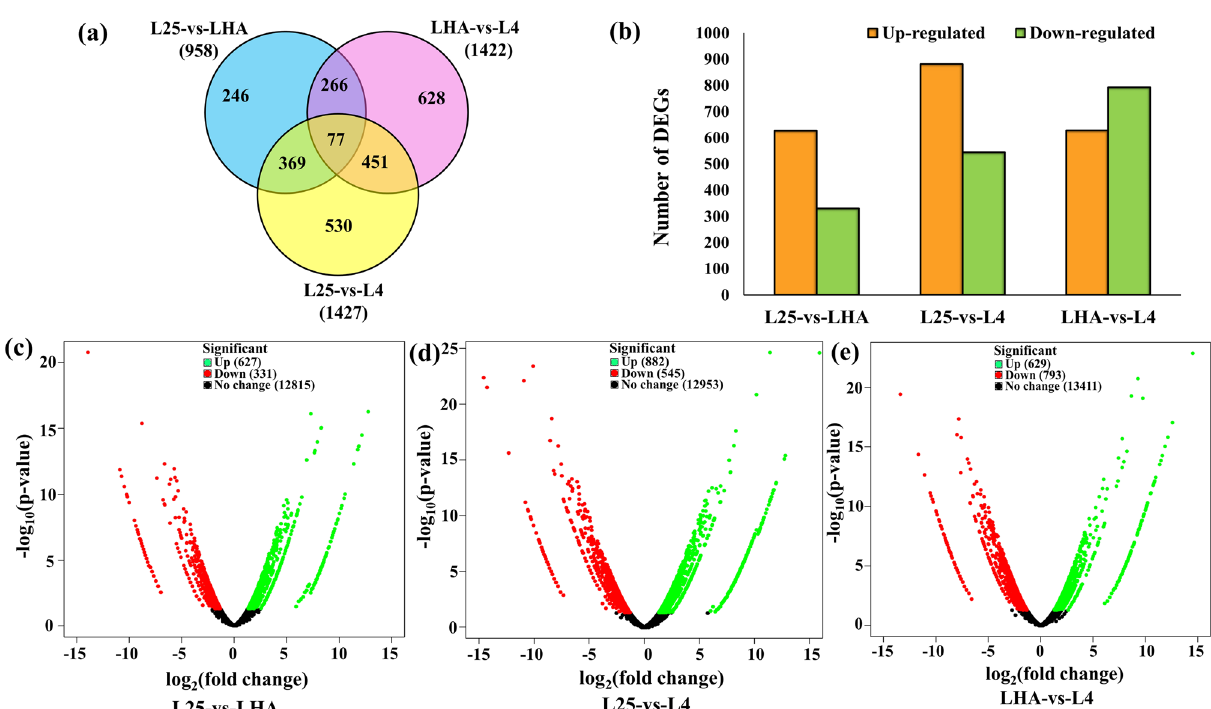
Figure 4. Venn diagram, histogram, and volcano plots of differentially expressed genes (DEGs). ( a) Venn diagram shows DEGs expressed in each of the three L25-vs-LHA, L25-vs-L4, and LHA-vs-L4 conditions. Transcripts common in two or more comparative conditions are enclosed in the overlapping portion of the circles. (b) The number of DEGs in comparisons between pairs of libraries. X-axis indicates the comparisons between L25-vs-LHA, L25-vs-L4, and LHA-vs-L4; y-axis indicates the number of DEGs. (c,d,e) Volcano plots of the distribution of DEGs between L25-vs-LHA, L25-vs-L4, and LHA-vs-L4 respectively. X-axis shows the log 2 fold change in gene expression. Y-axis shows the -log 10 (p-value). The further from 0 on x-axis, the greater the change in expression and the higher on y-axis, the greater the significance. The green dots indicate up-regulated, red dots indicate down-regulated, and black dots indicate no change in expression in